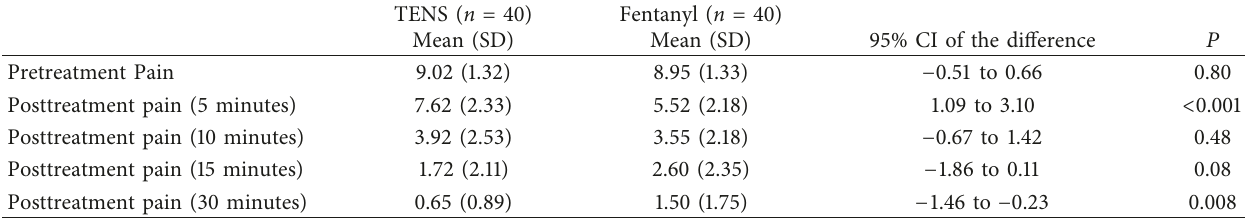
Table 2: Comparing pain score in TENS and fentanyl groups as measured by the visual analogue scale (VAS) ∗